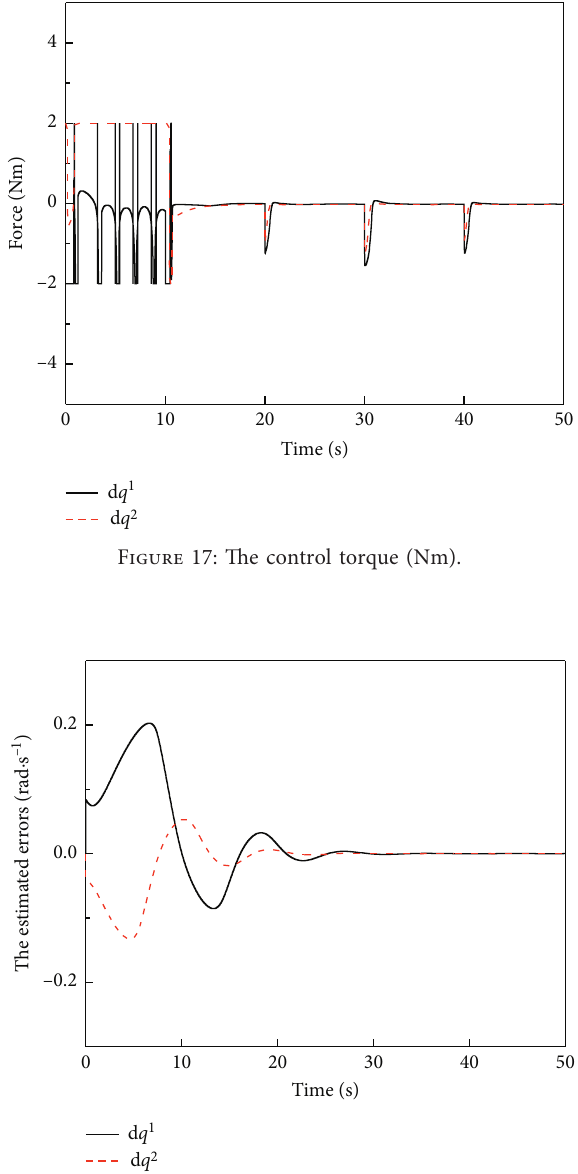
Figure 18: The estimated errors of FTISMDO